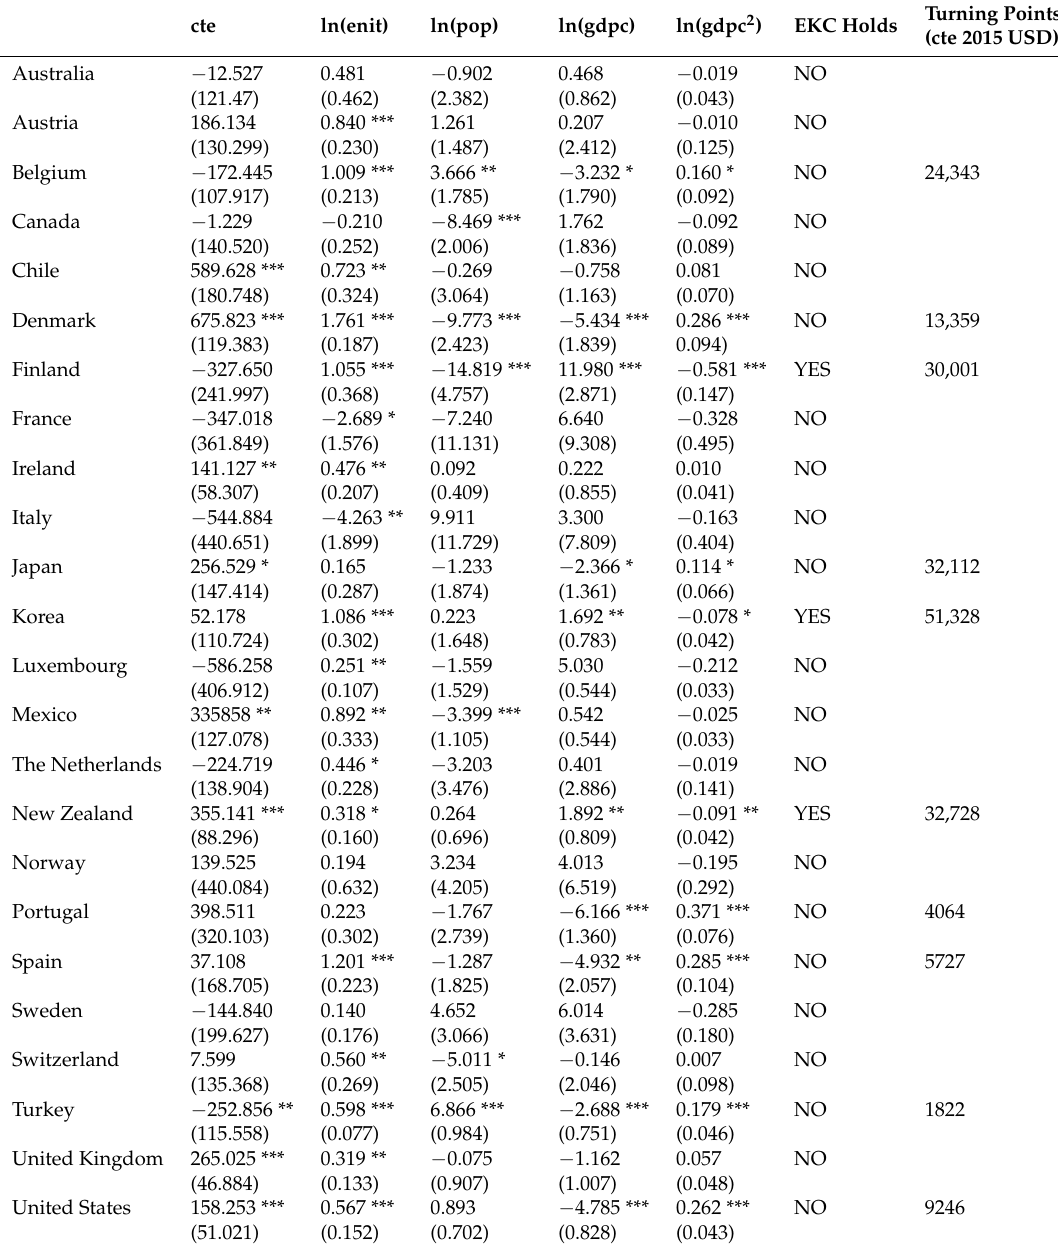
Table 4. Parametric estimates for the OECD countries. Fully parametric